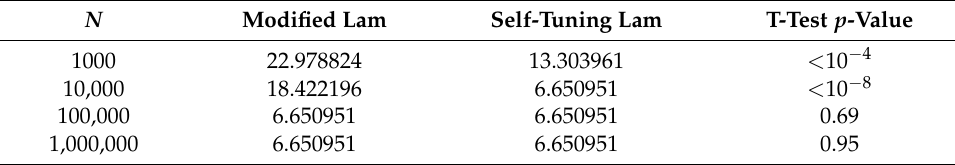
Table 12. Average solution for minimizing f 2,10 ( x ) . The minimum is f 2,10 ( x ) ≈ 6.65095.